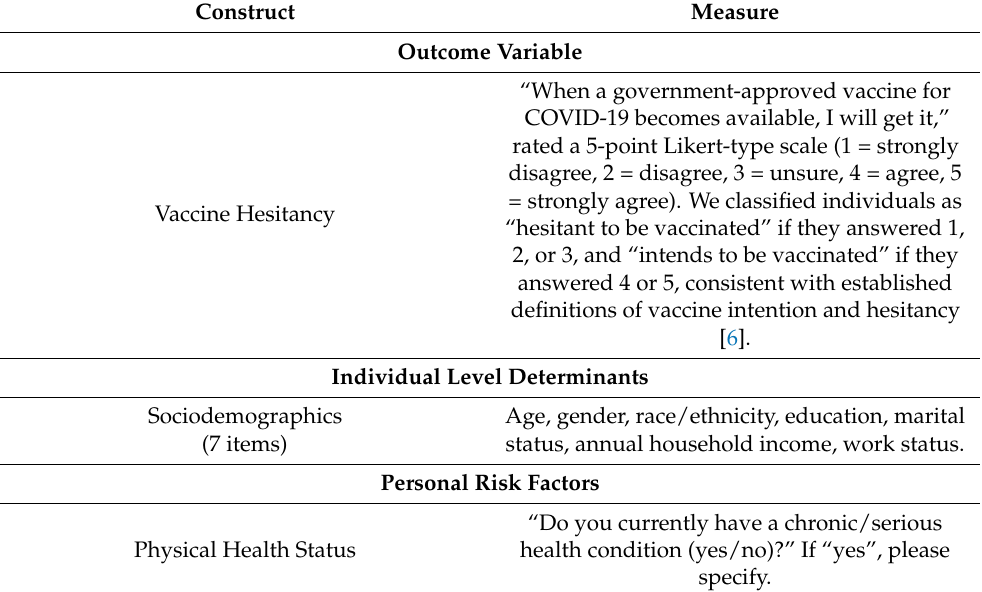
Table A1. Survey